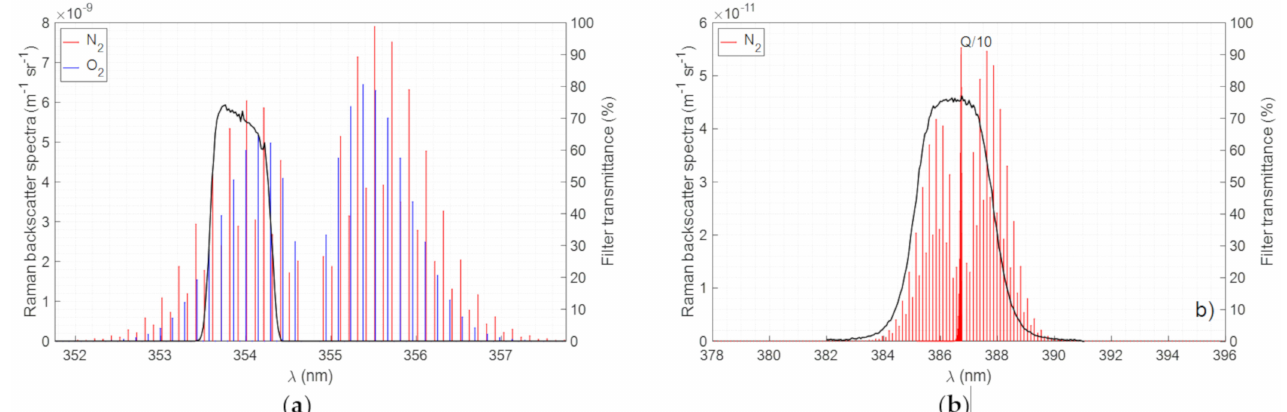
Figure 3. ( a ) N 2 and O 2 pure rotational Raman spectra (left axis) and filter transmittance (right axis) ( b ) N 2 vibro-rotational Raman spectrum (left axis) and filter transmittance (right axis). The spectra shown correspond to a 300 K temperature and to a 1013 hPa